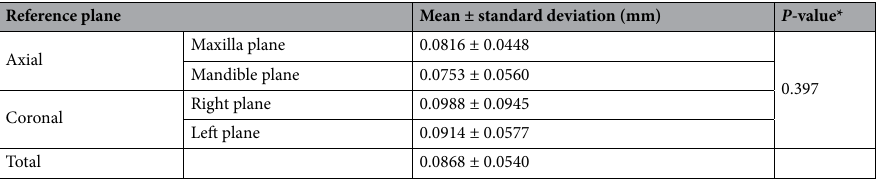
Table 1. Deviation of the digital models with metal artifact reduction algorithm (mean, standard deviation) and comparison of deviation according to the different reference planes. * P < 0.05 was considered to indicate statistical significance, and the P -value was calculated using analysis of variance